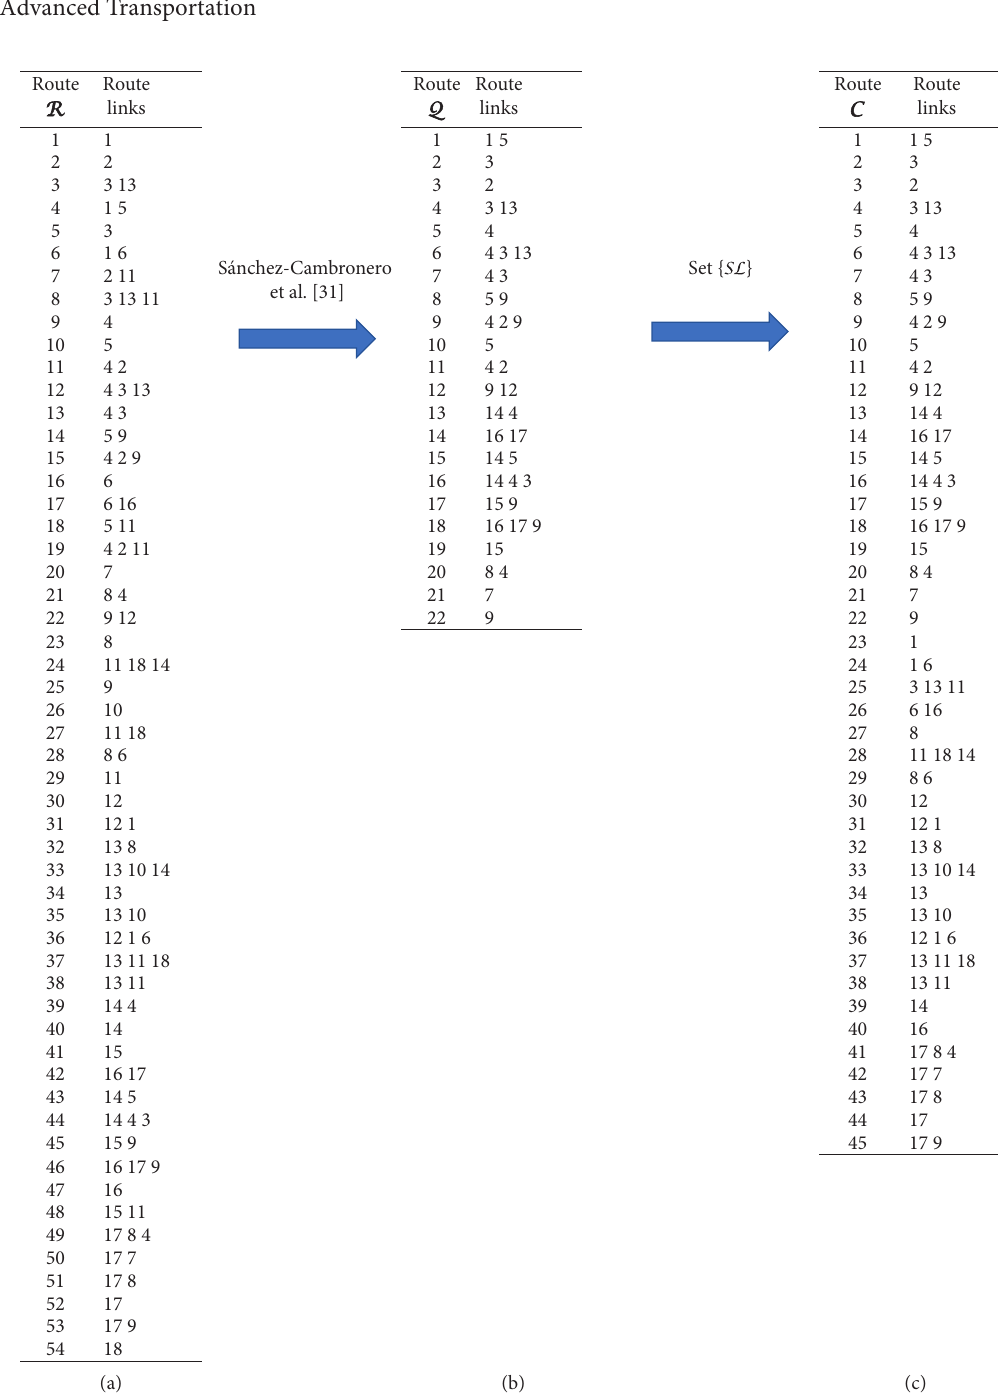
Figure 2: Operation scheme and sets of (a) reference routes { R }, (b) simplified routes { Q }, and (c) combination routes { C